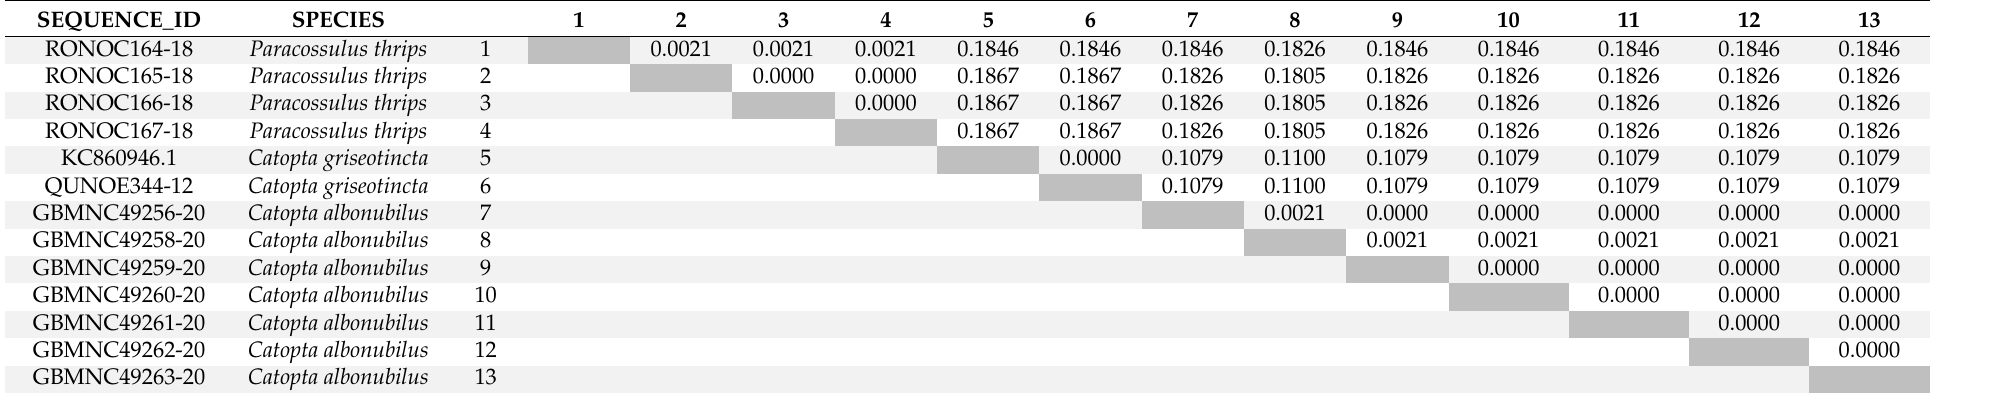
Table 4. The matrix with the genetic distances between P. thrips and Catopta